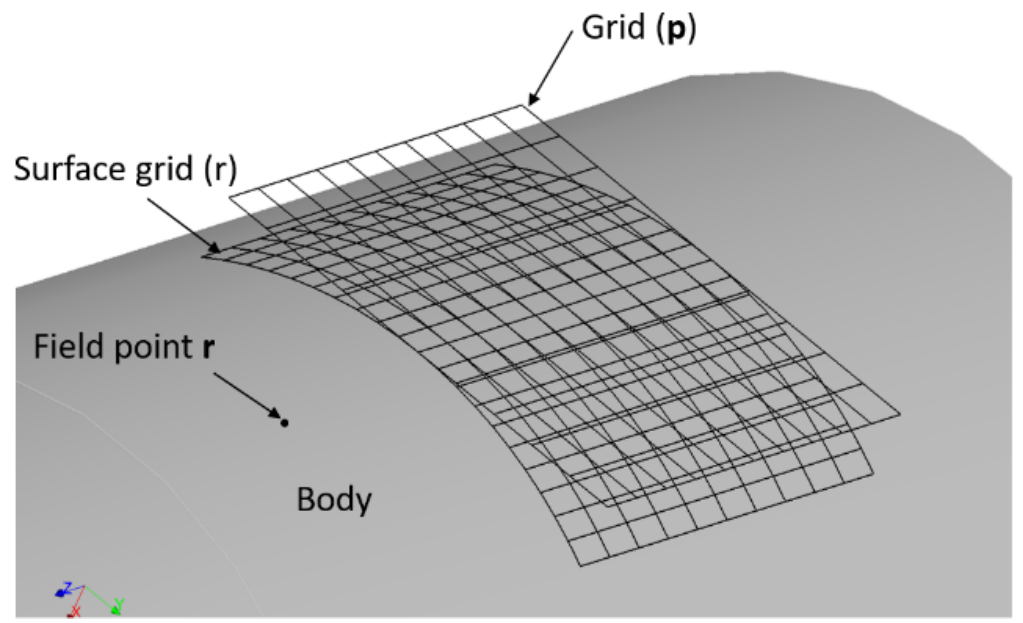
Figure 1. The contacting surface and the computational grid.